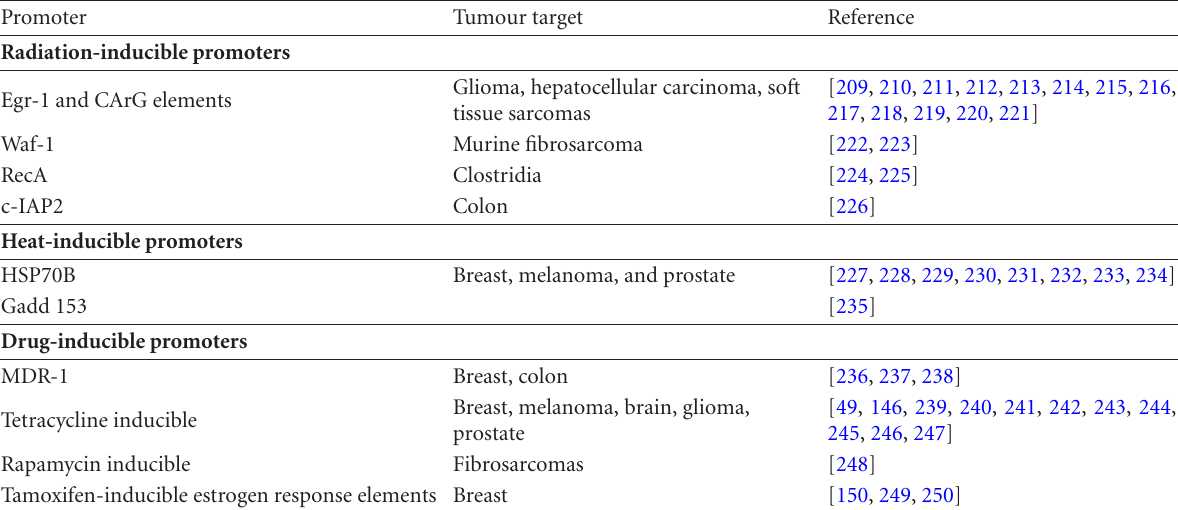
Table 4. Exogenously controlled inducible